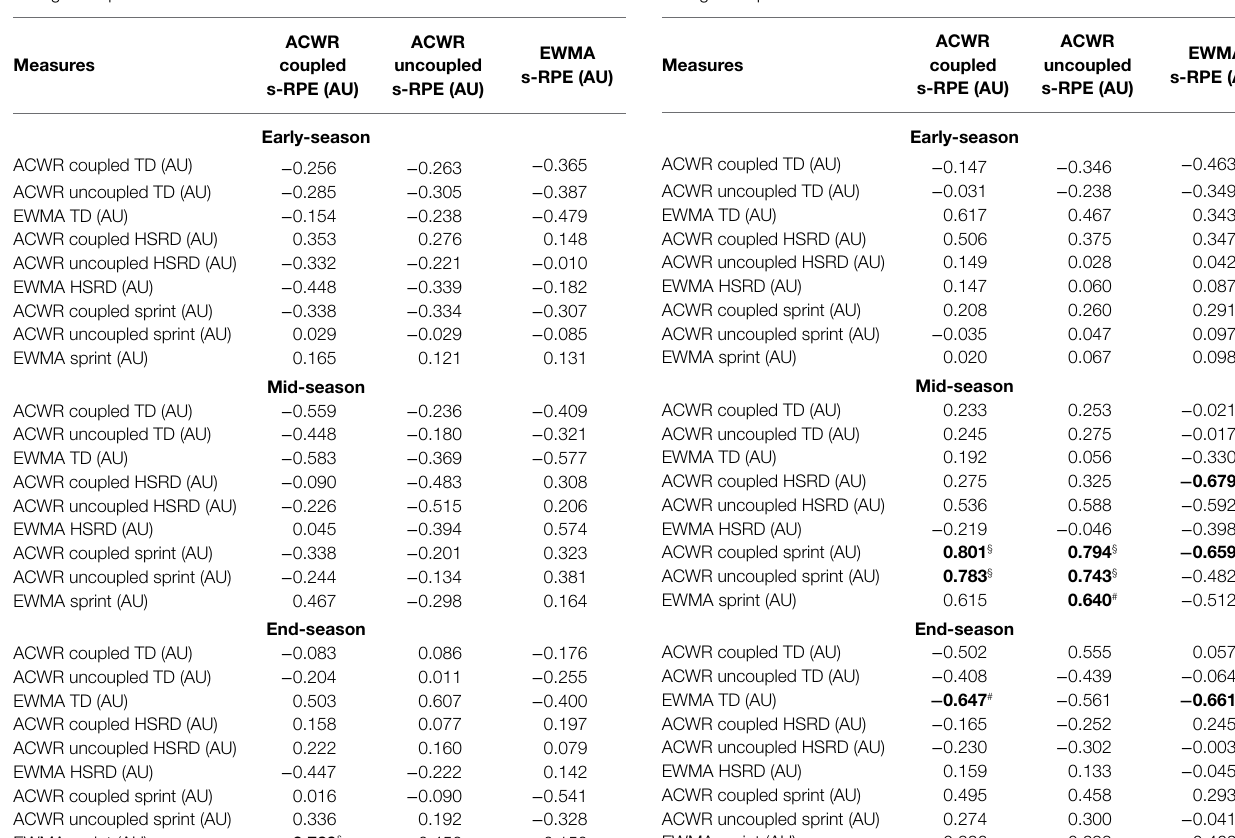
TABLE 4 | Correlation analysis between external and internal load measures during three periods of the in-season for the non-starter’s